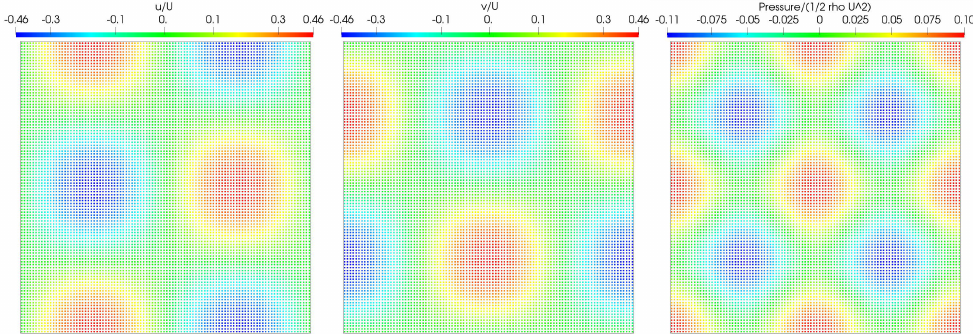
Figure 10. Taylor Green flow: Results for Re = 100 at t ∗ = 1. Left : u-velocity field; center : v-velocity field: right : pressure field.